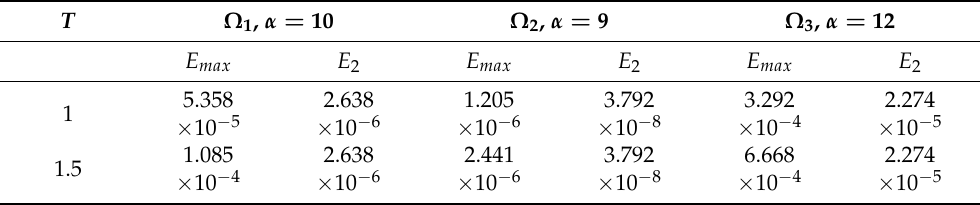
Table 2. E max and E 2 for the BSM method and the effect of time and domain for Example 3,